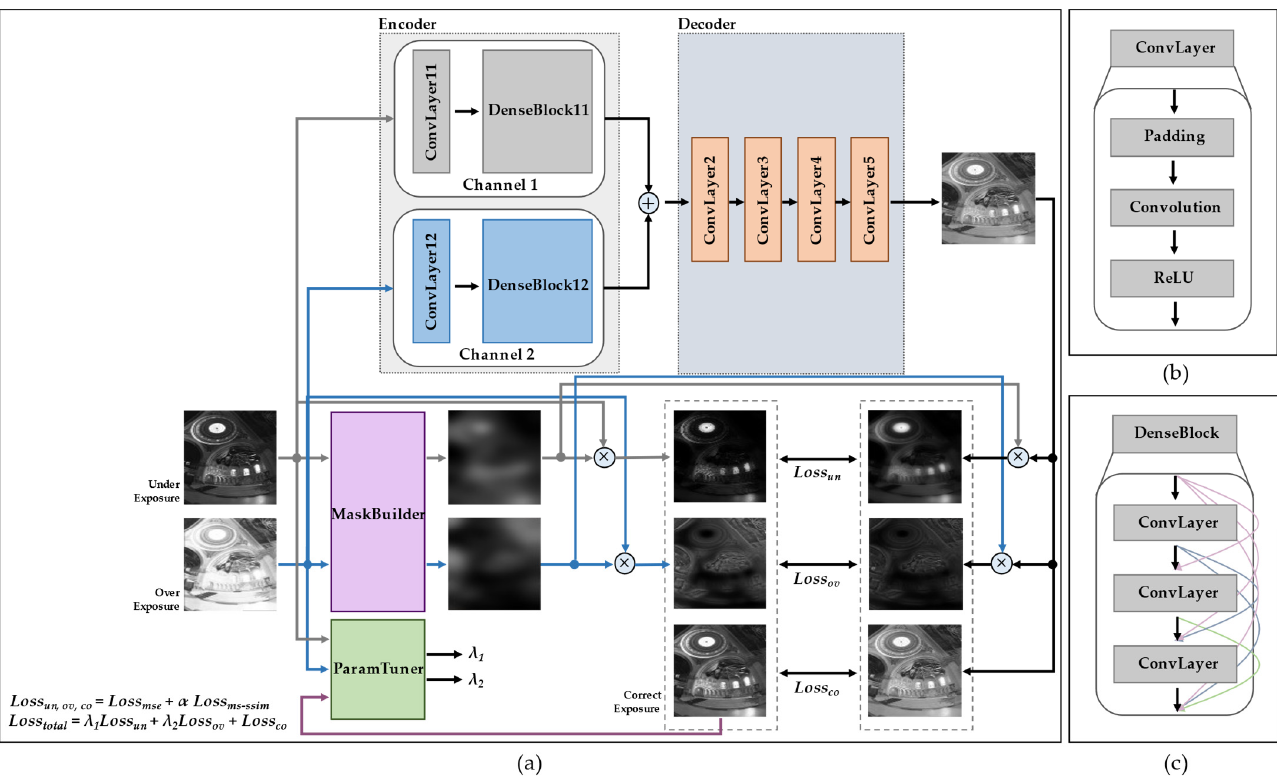
Figure 3. Framework of the proposed model: ( a ) the proposed training network with multi-task images; ( b ) detailed structure of ConvLayer; ( c ) detailed structure of DenseBlock.